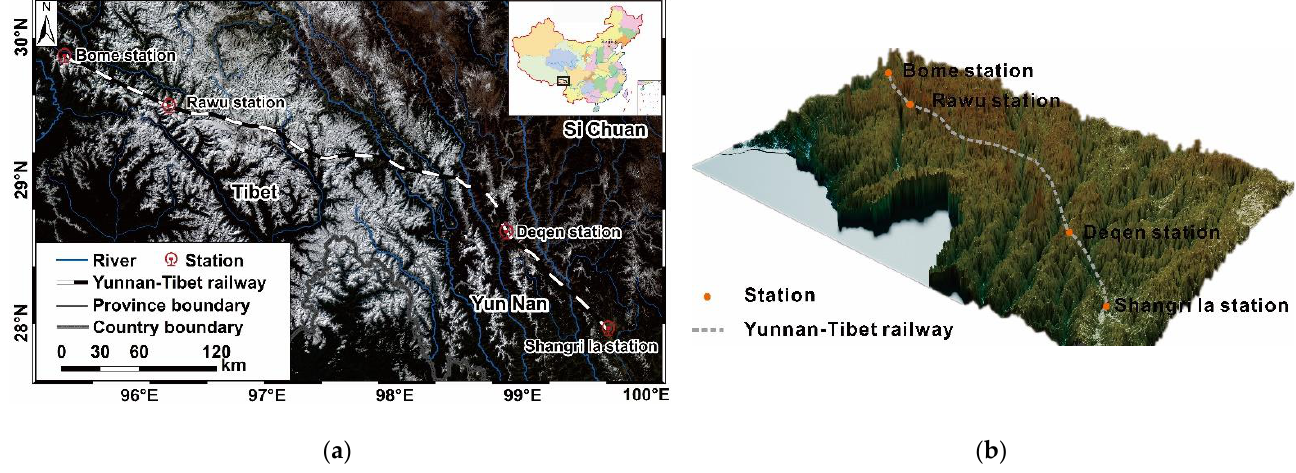
Figure 1. Location ( a ) and topography ( b ) of the Yunnan – Tibet railway.